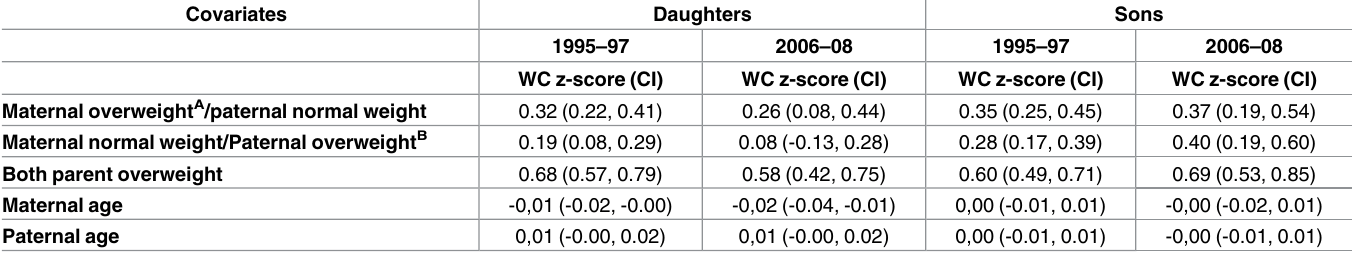
tively. No statistical interaction between sex and time points was found. Waist circumference based results. Associations between parental waist circumference categories and offspring waist circumference z-scores showed a similar pattern to the ones identified for BMI, with the strongest association identified when both parents were over- weight; 0.68 (95% CI: 0.57, 0.79) in daughters and 0.60 (95% CI: 0.49–0.71in sons in 1995–97 and 0.58 (95% CI: 0.42, 0.75) and 0.69 (95% CI: 0.53, 0.85) in 2006–08, daughters and sons, respectively (Fig 3, and Table 3). Table 3. Age adjusted association between parental waist circumferencebased overweight and offspring waist circumference z-score (standard deviations from their means) in 1995–97and 2006–08.